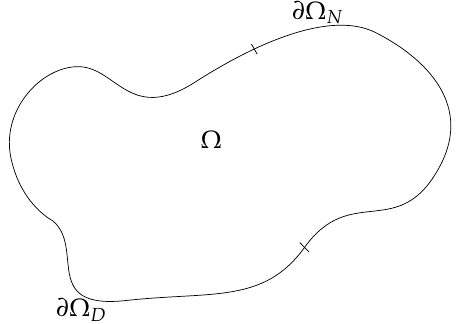
Figure 2. Schematics of the considered structure Ω